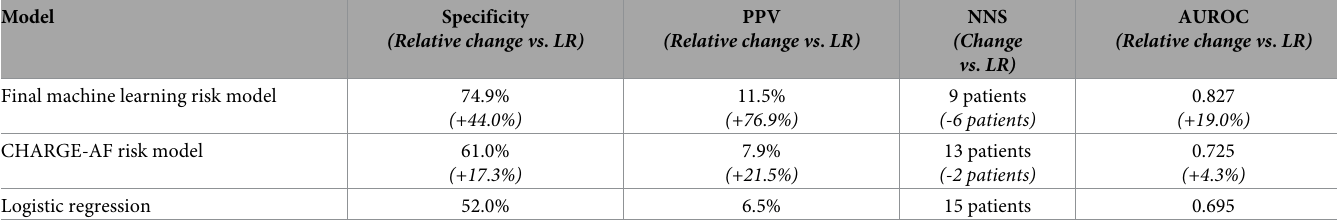
Table 3. Assessment of model performance at 75% sensitivity.